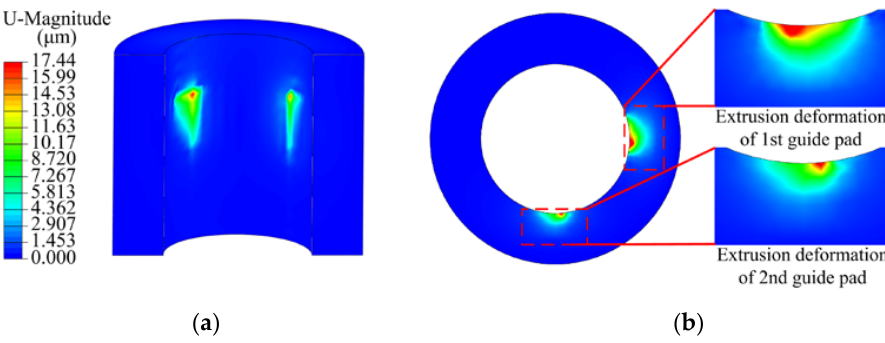
Figure 10. Extrusion deformation nephogram between the guide pads and hole wall: ( a ) cutting plane along workpiece axis; ( b ) cutting plane perpendicular to workpiece axis.